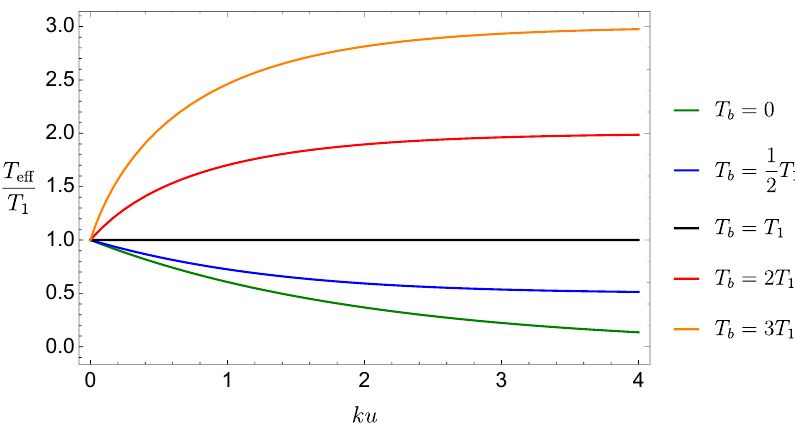
Figure 6 . The time dependence of effective temperature of black hole, which simply parametrizes the dynamical behavior of black